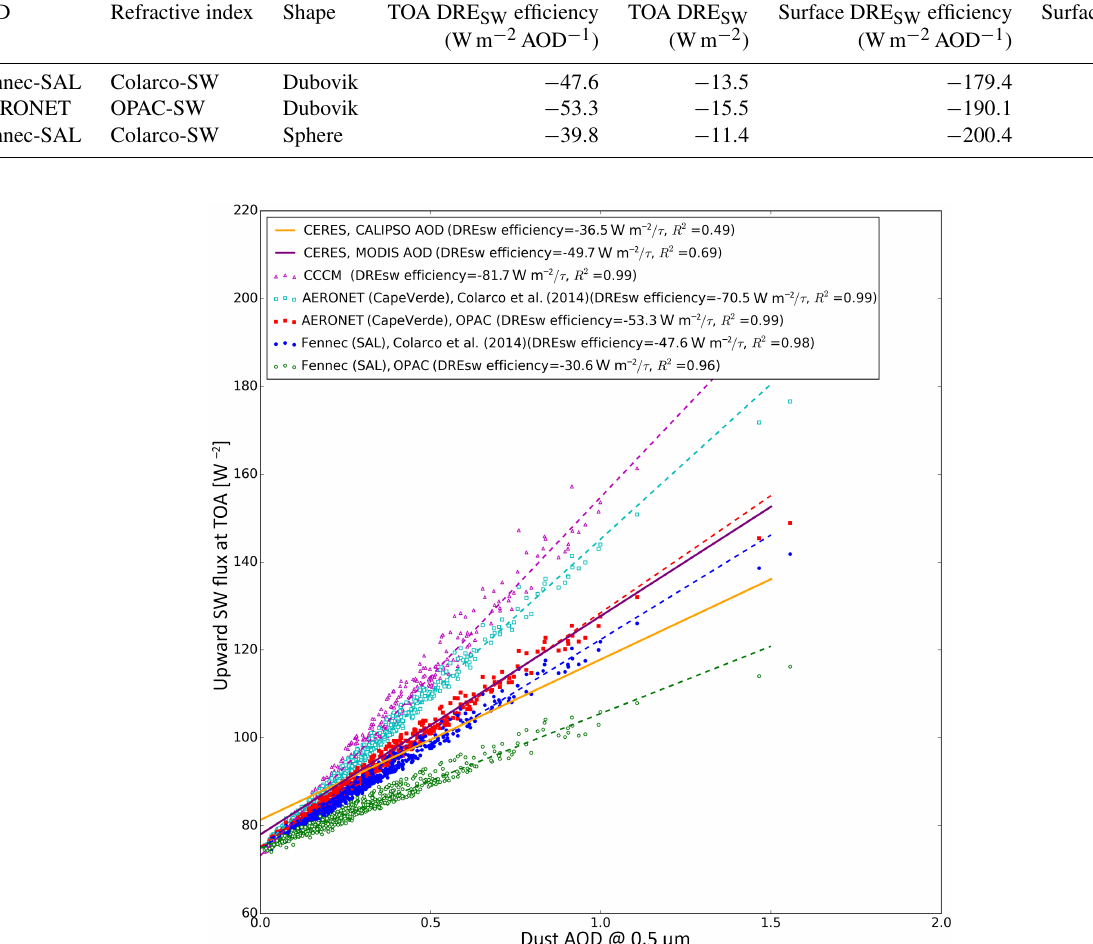
value (0.55) significantly larger than the commonly used